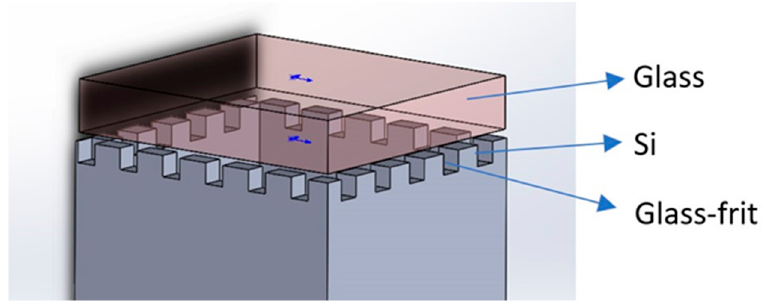
Figure 2. Sacrificial micro-channel-bonded alkali metal vapor cell.